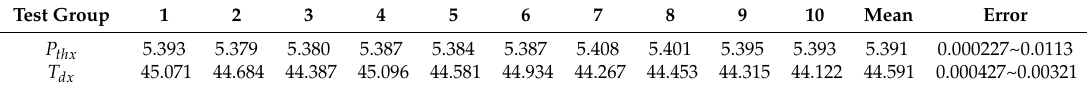
Table 5. Ten sets of P thx and T dx measured when the input current is 5